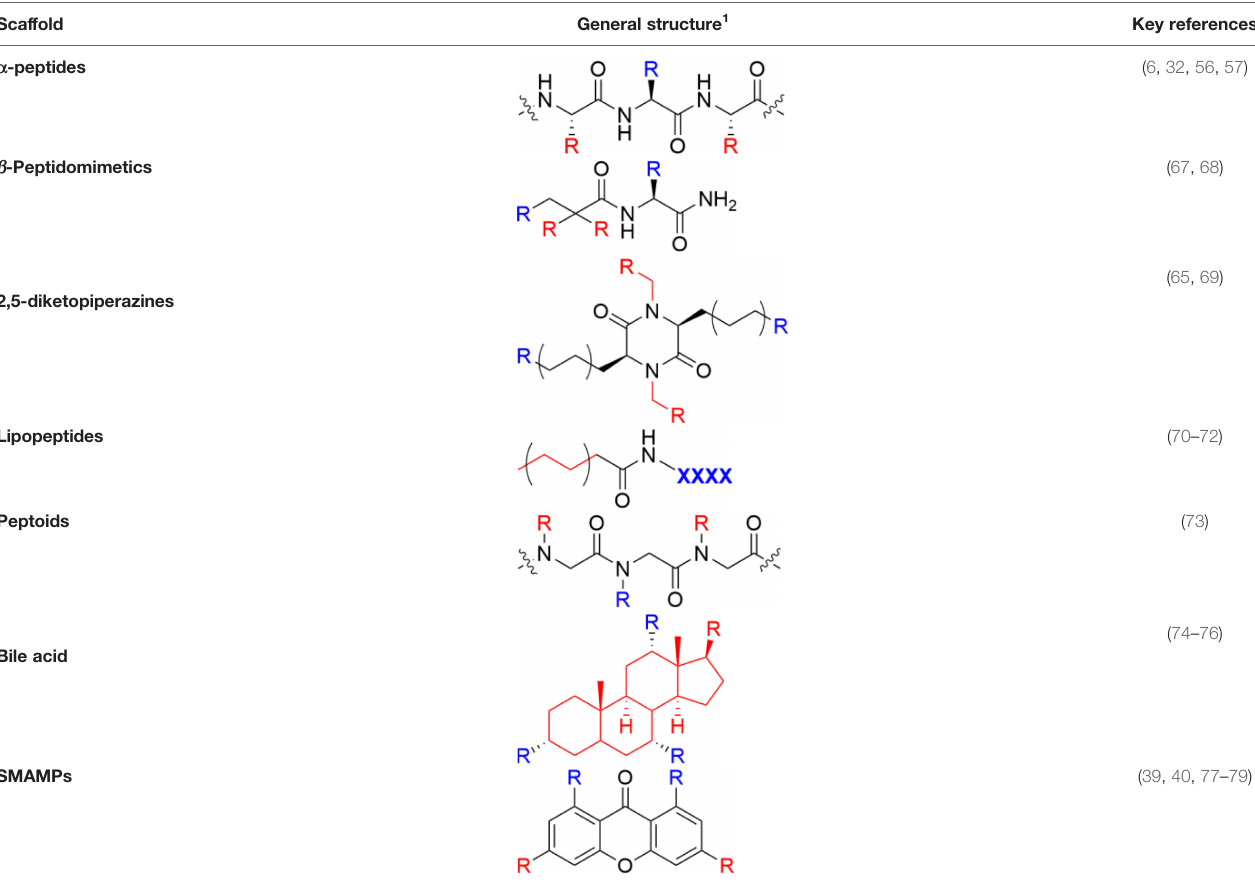
TABLE 1 | Major scaffold types used to generate small bioactive AMP mimics adhering to the 2 + 2 pharmacophore.